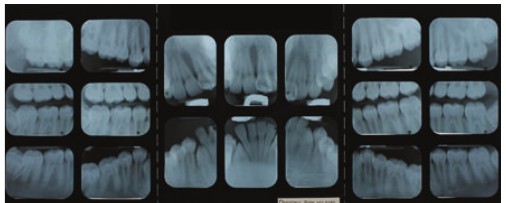
Figure 3: Initial full mouth radiographs.